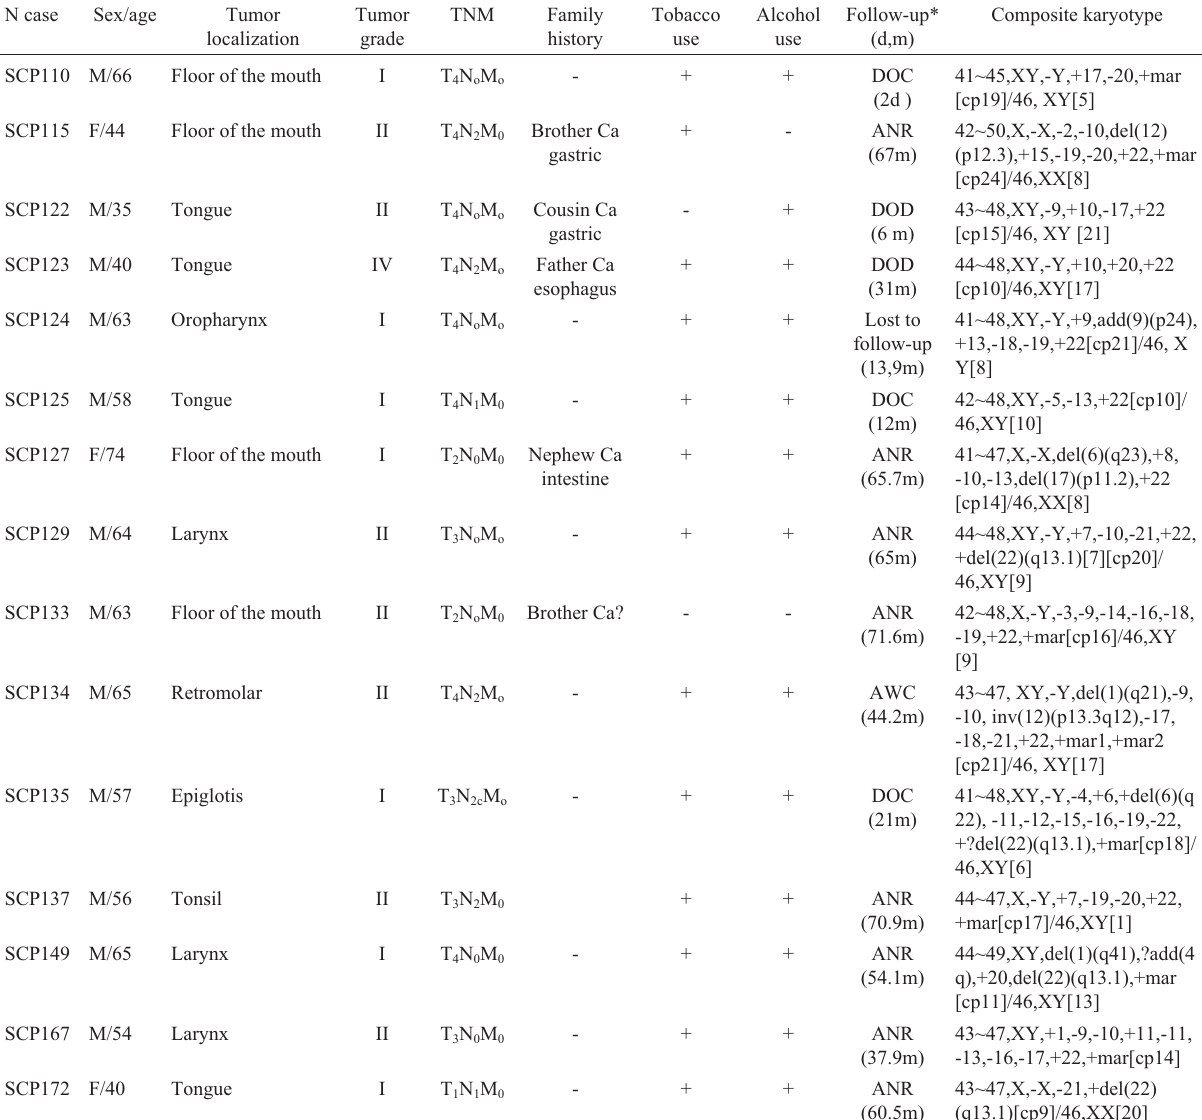
Table 1- Features of HNSCC cases: age, sex, histopathological diagnosis, TNM status, clinical data and composite karyotype. N